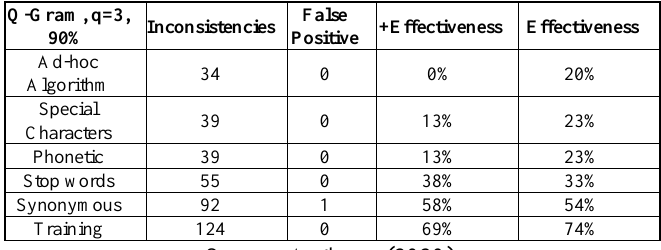
Table 8: Results obtained with data cleaning process using the algorithm Q-Grams, with q=3 and 90% similarity.